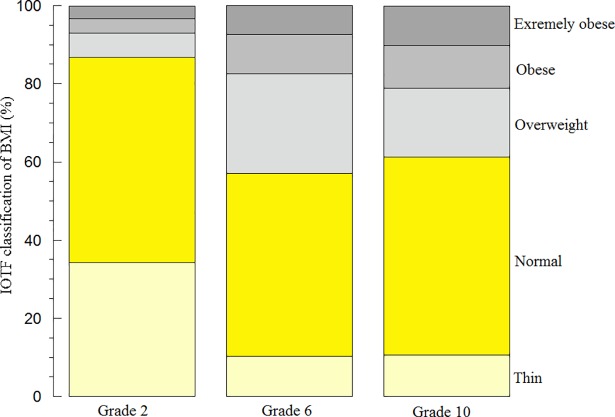
BMI of the studies children per IOTF, WHO, and CDC classifications.The values of BMI were classified as thin, normal, overweight, obese, or extremely obese according to IOTF (upper panel), WHO (middle panel), and CDC (lower panel) criteria.